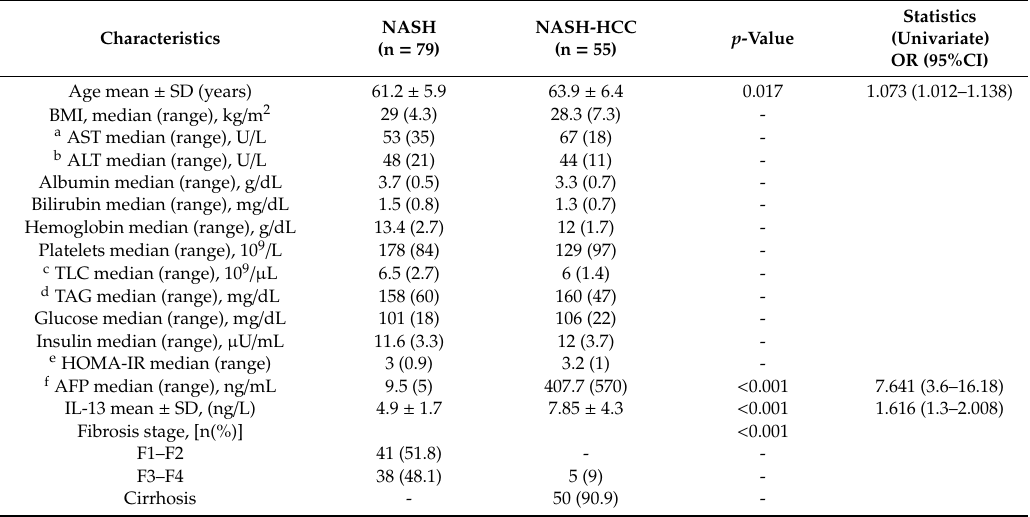
Table 1. Baseline clinical characteristics of studied patients included in the present